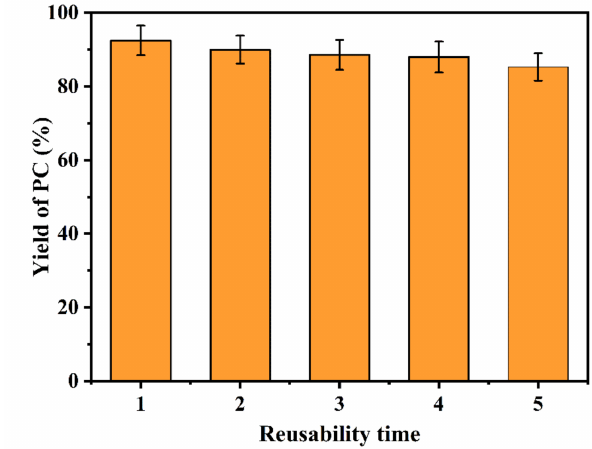
Figure 7. Recycling experiments of the benchmark reaction in the presence of the SMgAlO-5 catalyst. Reaction condition: n (PG) / n (urea) = 3; mass fraction of the catalyst = 1%; reaction time = 5 h; reaction temperature = 433